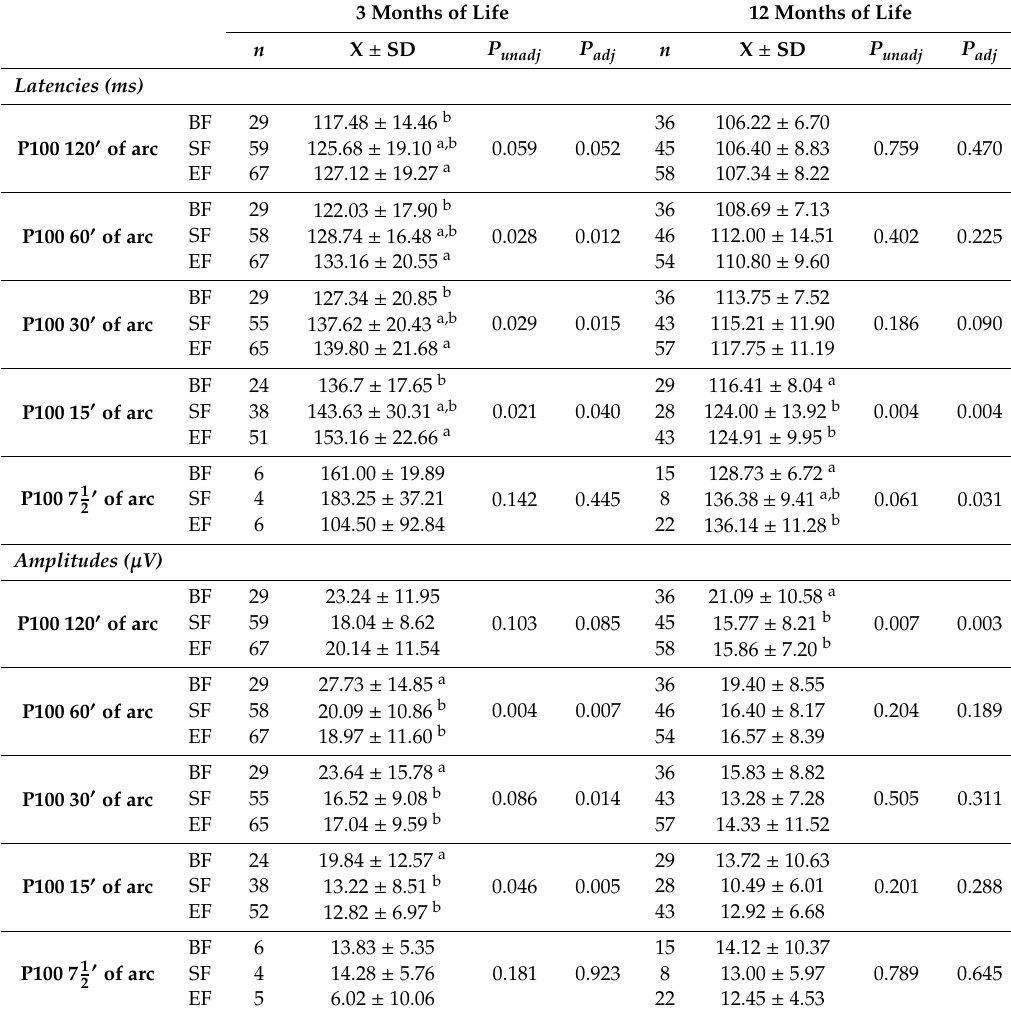
Table 4. Latencies and amplitudes of infant’s P100 wave cortical visual evoked potentials (cVEPs) at 3 and 12 months of age in infants participating in the COGNIS